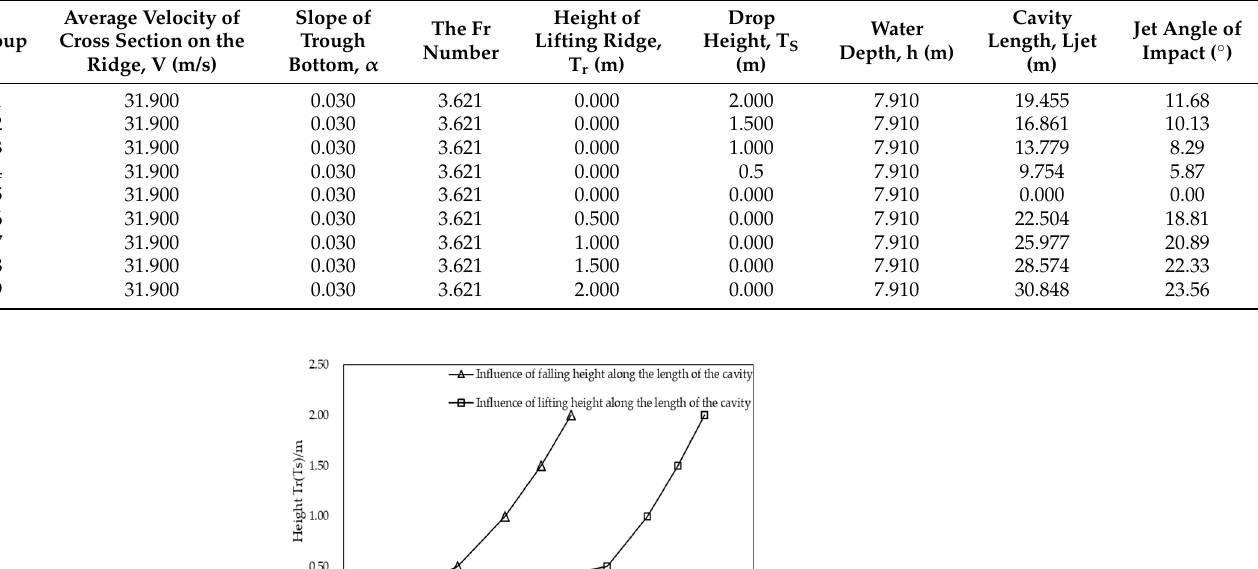
Table 2. Theoretical calculation and analysis of body type group table.